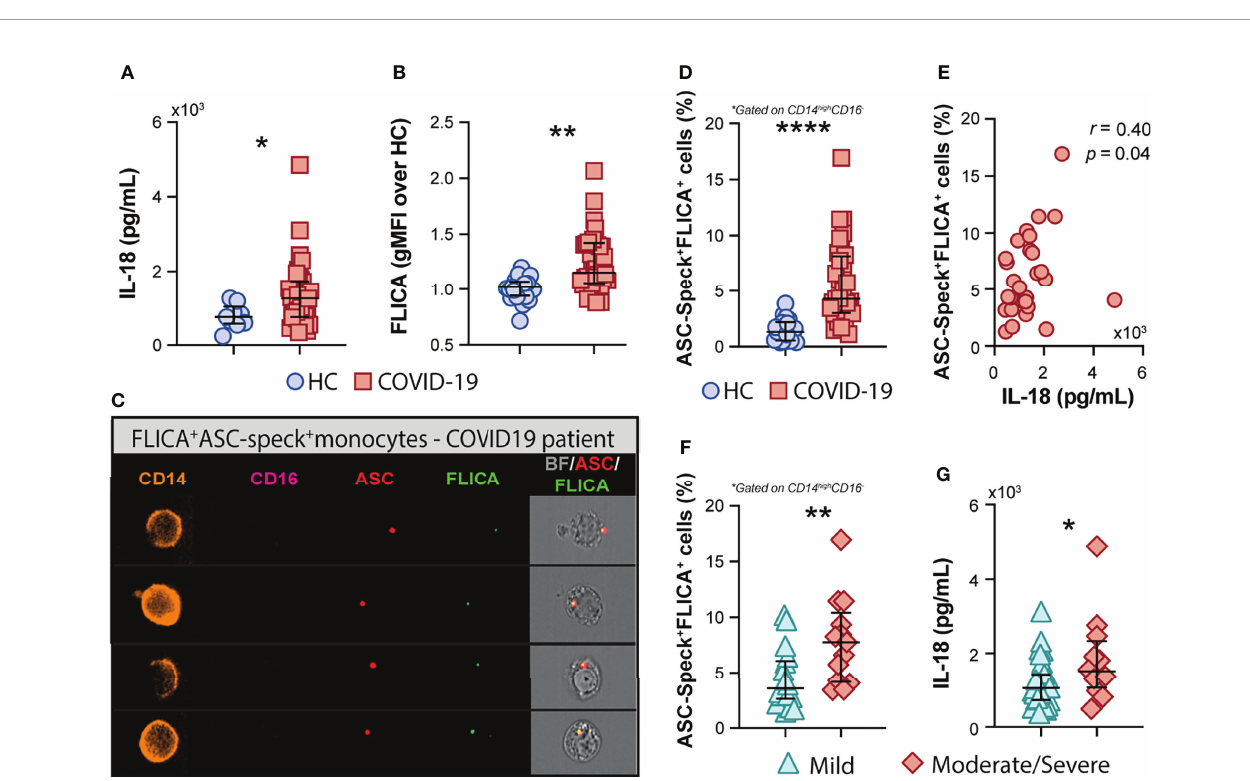
FIGURE 2 | COVID-19 patients exhibit a high frequency of monocytes displaying FLICA + ASC-speck formation. (A) Plasma levels of IL-18 were compared between healthy control (HC) donors (n = 9) and COVID-19 patients (n = 39). Lines represent median values and interquartile ranges. (B) PBMCs were incubated with the fl uorochrome inhibitor of caspase-1/4/5 (FLICA) and the geometric mean fl uorescence intensity (gMFI) of FLICA within the CD14 high CD16 − monocyte subset was compared between HC (n = 21) and COVID-19 patients (n = 38). Data are presented as median with interquartile range. (C) PBMCs from HC (n = 24) and COVID- 19 patients (n = 32) were incubated with FLICA, stained for monocyte identi fi cation and intracellular ASC and acquired by Imaging fl ow cytometry. Representative images showing respectively: CD14, CD16, ASC and FLICA fl uorescence followed by a composite image containing bright fi eld (BF), and the fl uorescence of ASC and FLICA merged, were selected from a COVID-19 patient. (D) The percentage of monocytes showing spontaneous FLICA + ASC-Speck formation was quanti fi ed after application of Modulation_Morphology (M11,Ch11)_11-ASC feature, followed by Bright Detail Similarity R3_MC_11-ASC_2-FLICA, inside the CD14 high CD16 − monocyte gate, by using IDEAS software. Lines represent median values and interquartile ranges. (E) Spearman correlations between plasma levels of IL-18 and the percentage of ASC-speck + FLICA + CD14 high CD16 − monocytes in COVID-19 patient samples. Percentage of ASC-speck + FLICA + cells (F) and plasma levels of IL-18 (G) were compared between COVID-19 patients experiencing mild symptoms (n = 18 and n = 28, respectively) and moderate to severe cases of COVID-19 (n = 13 and n = 12, respectively). Lines represent median values and interquartile ranges. Data were analyzed using the Mann – Whitney test. *P < 0.05, **P < 0.01, ****P <